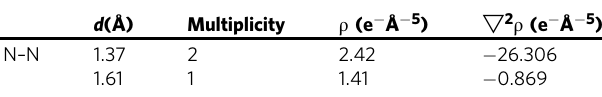
Table 1 Topological analysis of N – N bonding in the I 4 1 / a structure at ambient